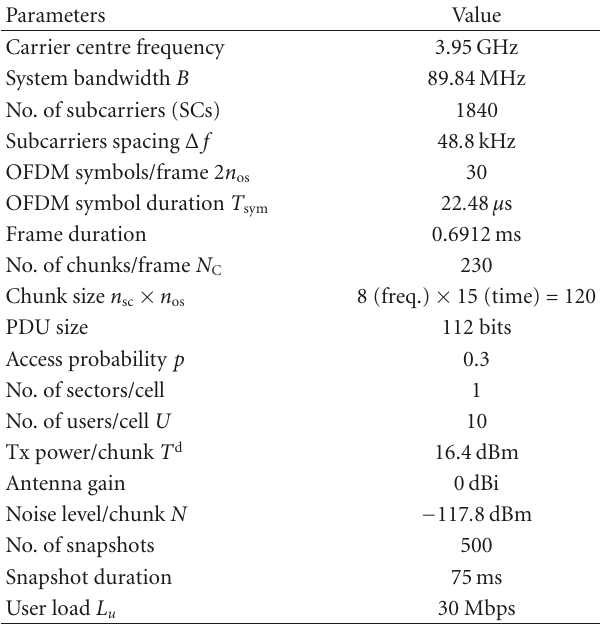
Table 1: Simulation parameters.